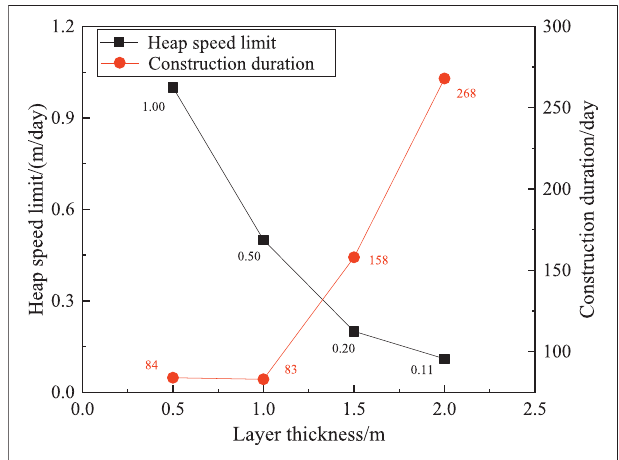
FIGURE 13 | Variations of heap speed limit and construction duration with layer